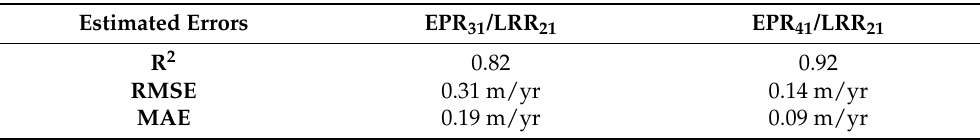
Table 6. The estimated errors of the EPR correlation for the 2021–2031 and 2021–2041 periods compared to the 1945–2021 LRR rates.